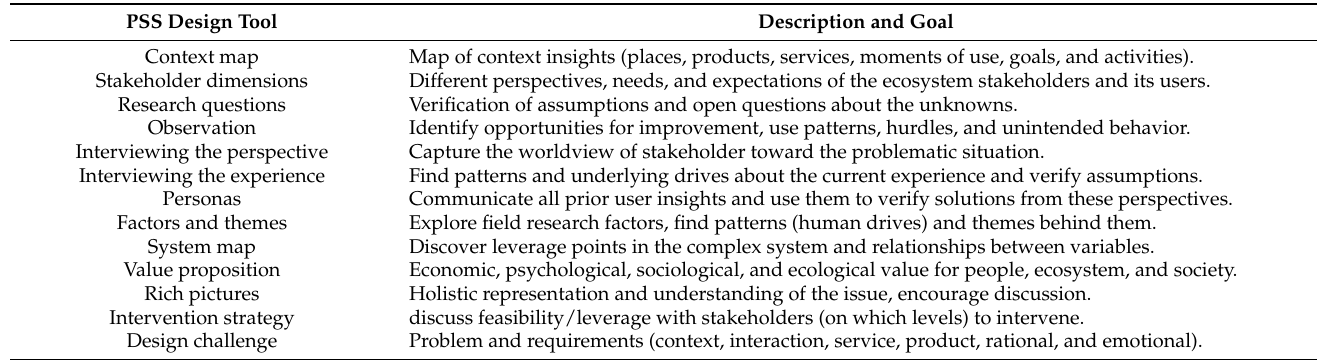
Table 4. PSS design tools and descriptions during the understand